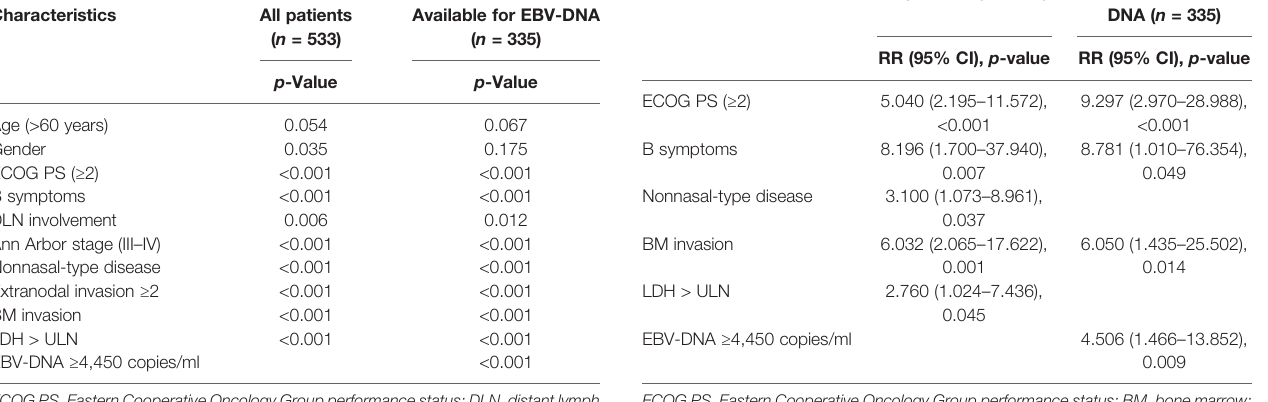
TABLE 2 | Univariate analysis showing the association of variables with NK/T-LAHS. Characteristics